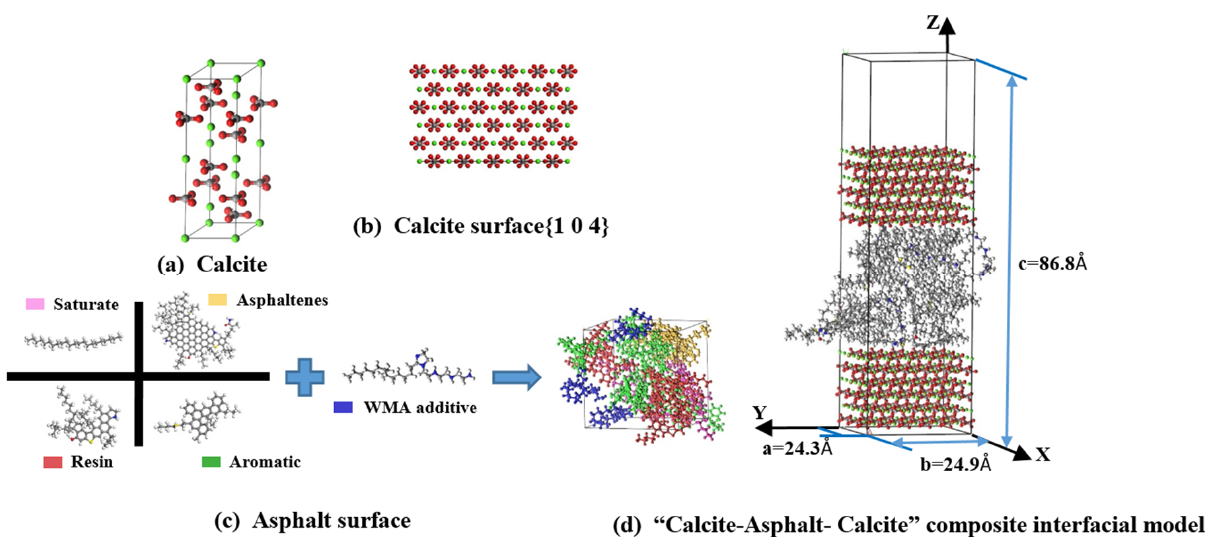
Figure 4. The structure model of the shear flow of asphalt confined between calcite (104) surfaces ( a ) calcite; ( b ) calcite (104) surface; ( c ) asphalt surface; ( d ) “calcite–asphalt–calcite” composite interfacial model.